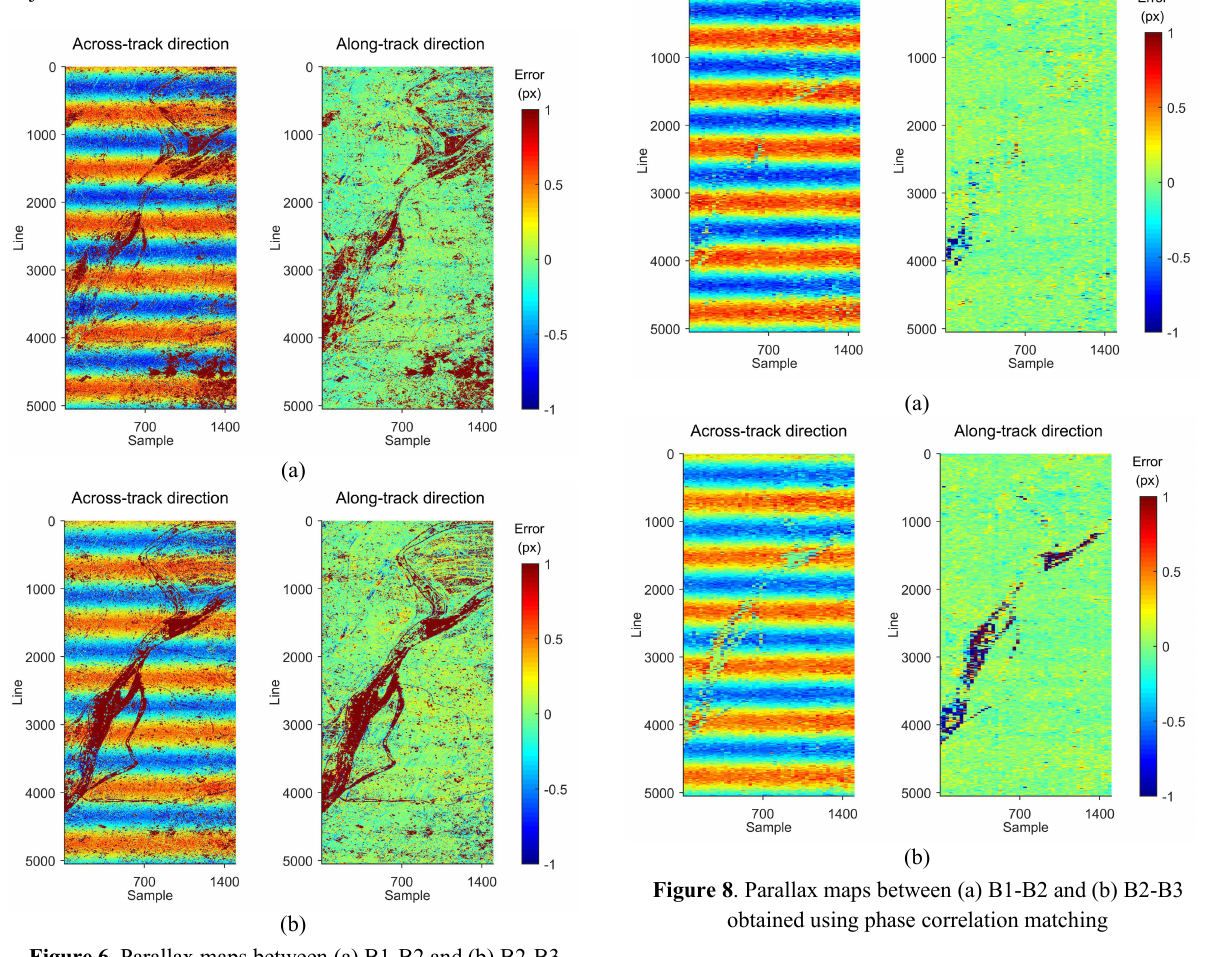
Figure 6 . Parallax maps between (a) B1-B2 and (b) B2-B3 obtained using correlation coefficient and least squares